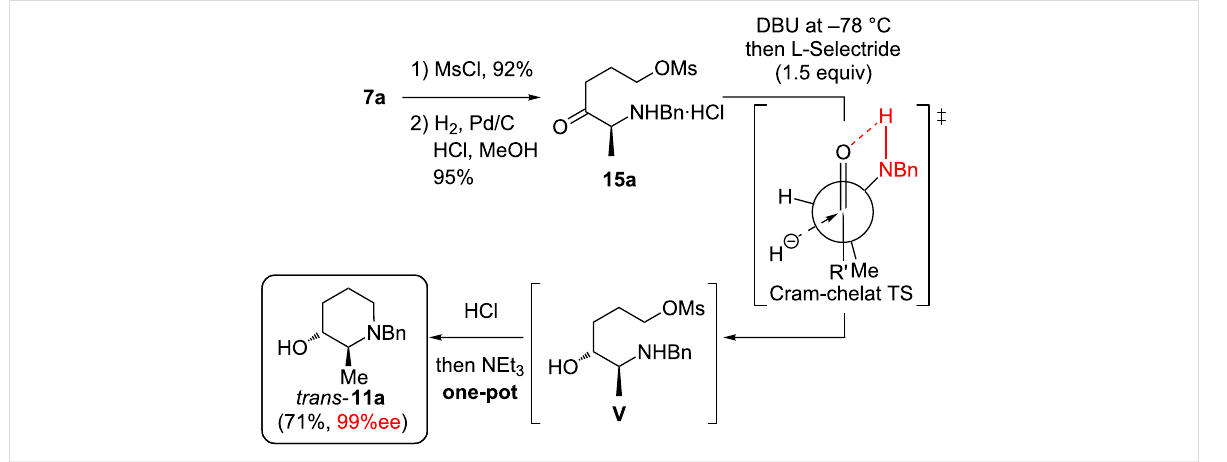
Scheme 7: Synthesis of trans -piperidinol 11a in excellent ee.